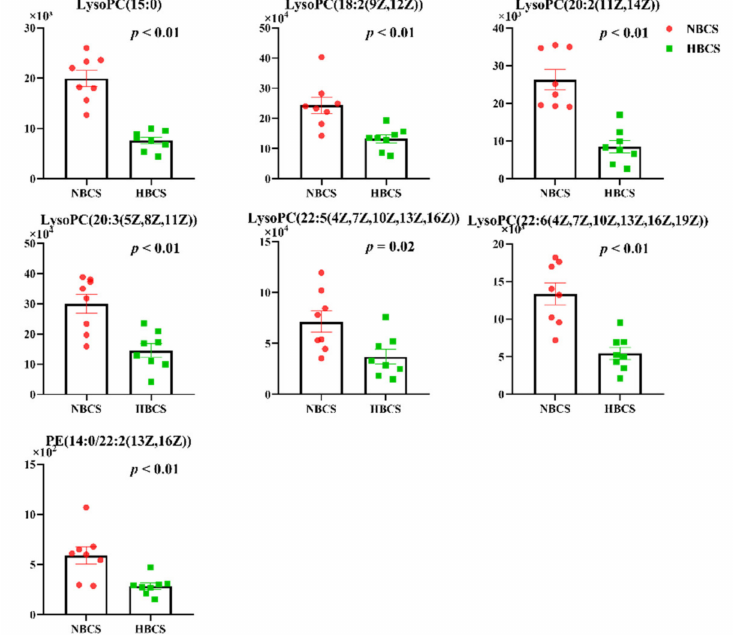
Figure 2. The plasma abundance of seven significantly di ff erentiated metabolites identified by untargeted LC-MS metabolomics in cows with di ff erent calving body condition score. NBCS, normal body condition score; HBCS, high body condition